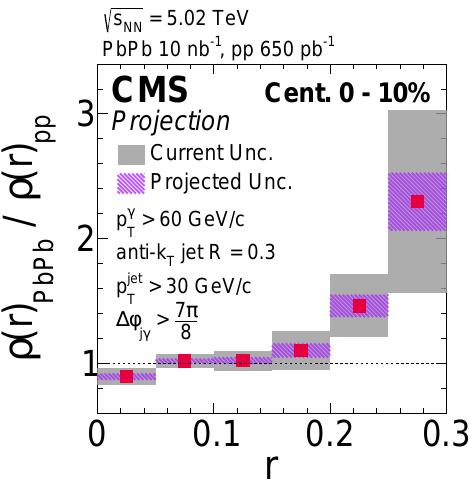
Figure 1: Ratio of the density of particles as a function of the radius r from the central axis of a photon-tagged jet in central PbPB collisions relative to pp collisions [ 5 ] . Projected systematic uncertainties on the HL-LHC measurement are shown compared to current